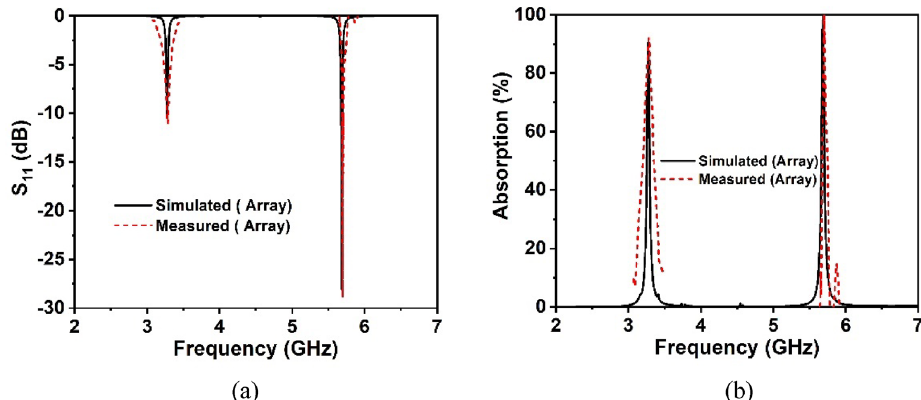
Figure 23. Measured and CST simulated results ( a ) S 11 response in dB and ( b ) absorption for a fabricated 2 × 2 array of the absorber.